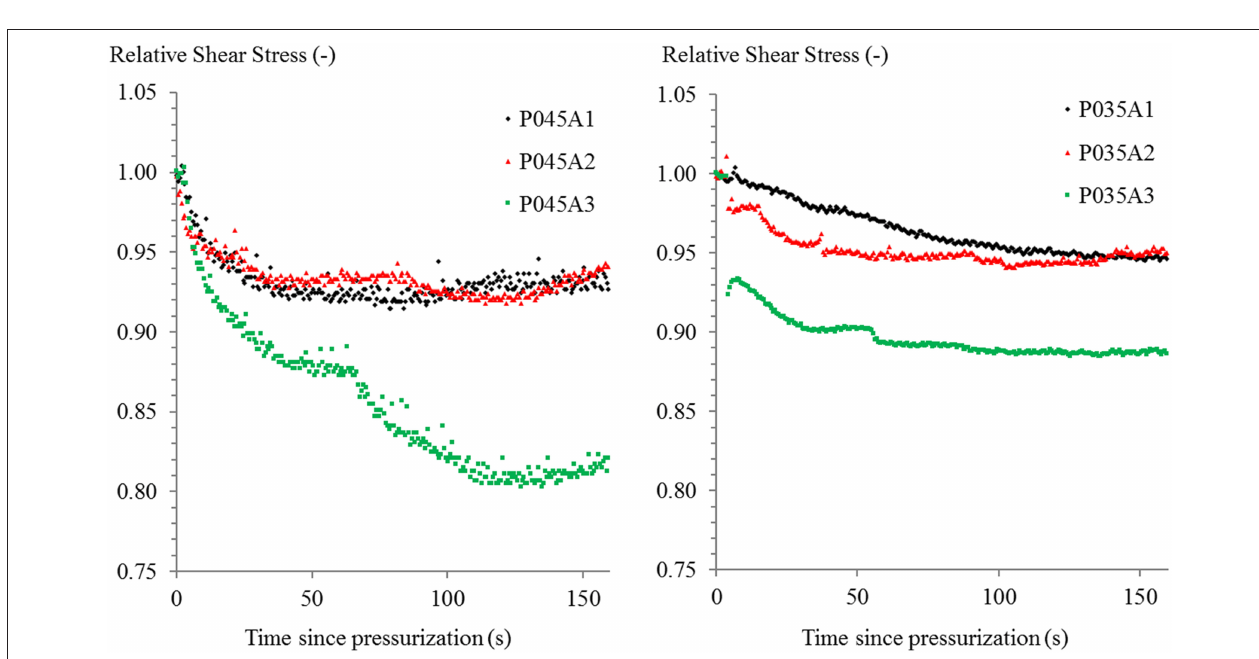
FIGURE 7 | Comparison of the relative shear stress response to pressurization over time of w/c = 0.45 (left) and w/c = 0.35 (right) mixtures. Pressure steps are not shown.